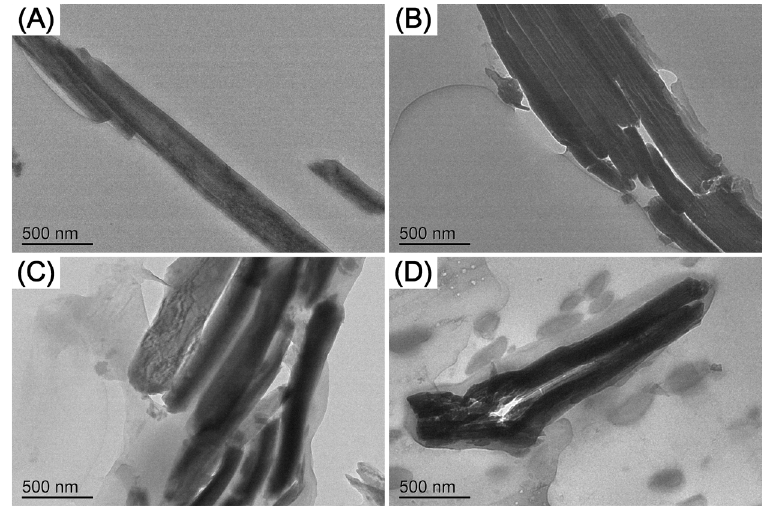
Figure 3. TEM micrographs of PLA/ZrP/E − MA − GMA (wt/wt/wt) blends with different composi- tions: ( A ) 97/3/0, ( B ) 92/3/5, ( C ) 82/3/15, and ( D ) 72/3/25.